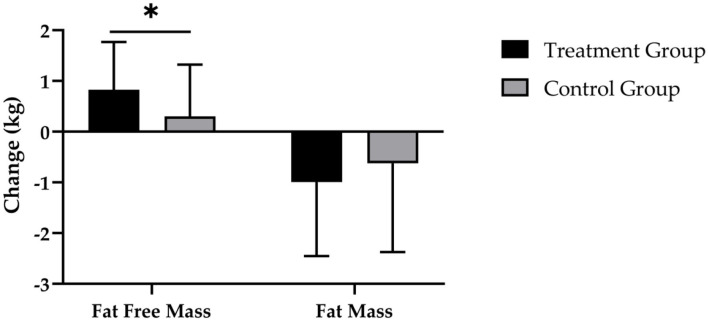
Changes in fat free mass and fat mass after 12 weeks of intervention in treatment group (n = 28) and control group (n = 31). Values are means ± SD for n subjects. *Significantly different (p < 0.05) by repeated-measures ANOVA (time × group interaction).